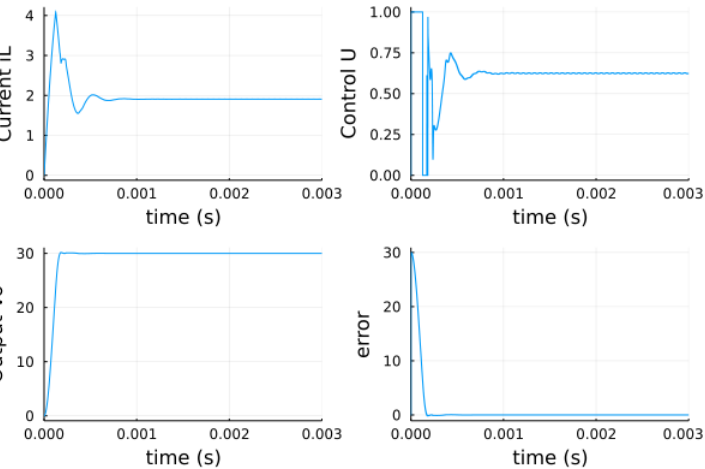
Figure 5. The output response of the Buck converter controlled by GAPID and optimized by PSO: inductor current i L , output voltage V o , control signal U , and instant